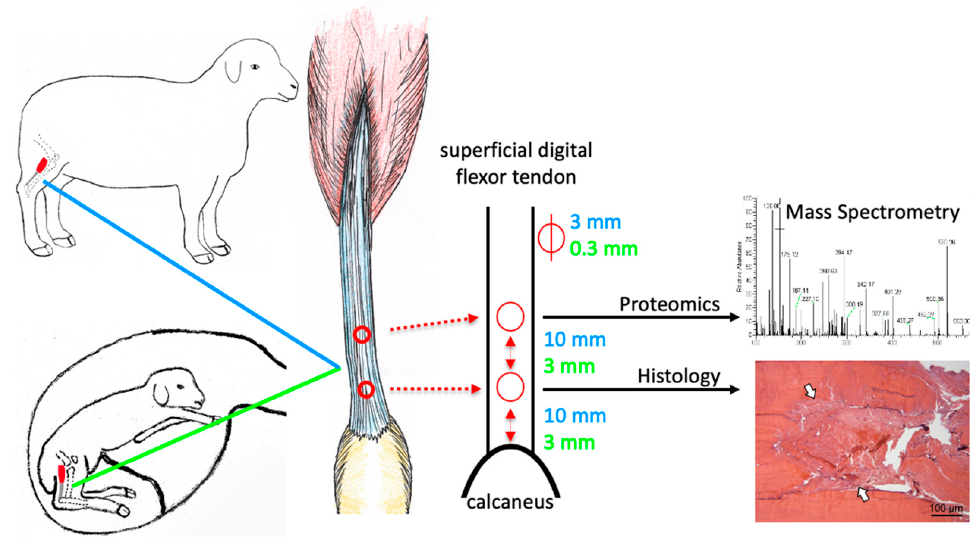
Figure 1. Tendon lesions were created in the superficial digital flexor tendon of adult and fetal (day 80 gestation) sheep using a biopsy punch of 3 mm (adult) and 0.3 mm (fetus) diameter in a caudocranial orientation. The tendon lesion locations and sizes are indicated in blue for adult and in green for fetal sheep. The distal lesion was created 10 mm (adult) and 3 mm (fetus) proximal to the calcaneus, the proximal lesion equidistant thereof. Samples were harvested at three days post-injury (pi), and the injury response relative to uninjured controls (for fetal sheep: uninjured twins) was compared between age groups using mass spectrometry and histology.